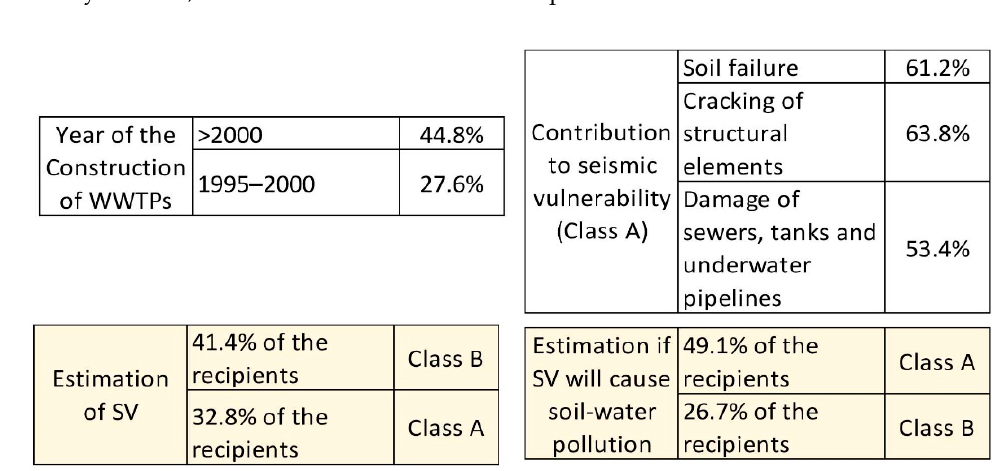
Figure 8. Structural vulnerability of the WWTPs in the post-seismic period in Greece. (c) Part 3: NSV parameters and their estimation from the recipients during the post- seismic period are presented in Figure 9.